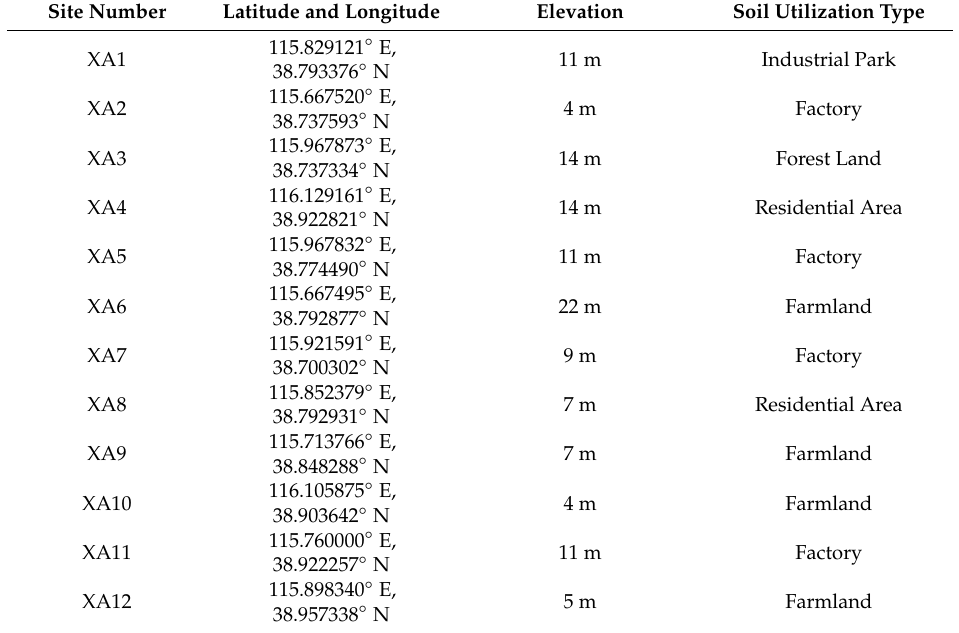
Table 1. Location of sampling points and soil utilization